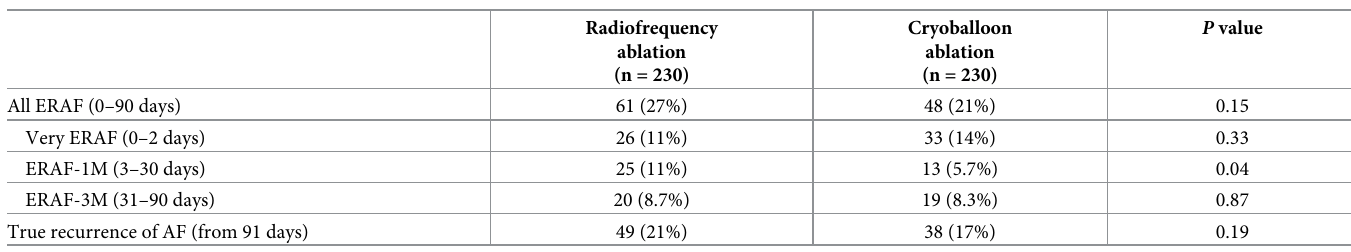
Table 2. Incidence of AF recurrence.